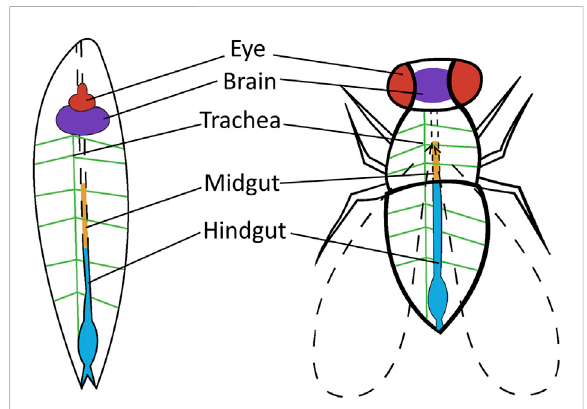
FIGURE 2 Drosophila tissue or organs used for cancer research. Tissue or organs are shown in the Drosophila larvae and Drosophila adult that are utilized in human cancer research. Thyroid cancer is targeted to the eye of adult Drosophila (red). Brain cancer is targeted to the brain of adult and larvae Drosophila (purple). Lung cancer is targeted to the trachea of larvae Drosophila (green) and colorectal cancer is targeted to the midgut (orange) and hindgut (blue) of adult Drosophila